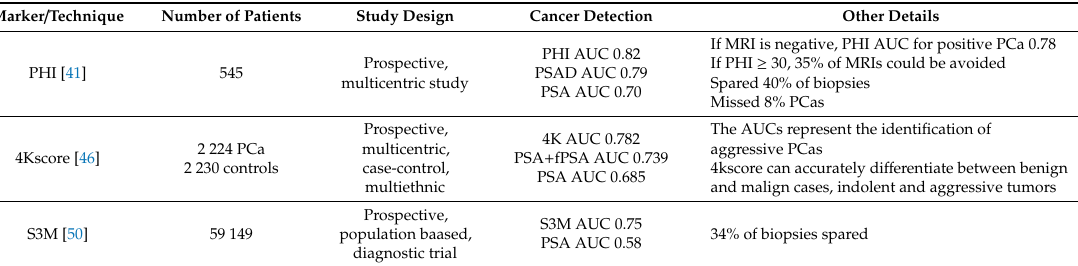
Table 2. Representative studies for recent advances in diagnose of PCa (inclusion criteria: study design and number of